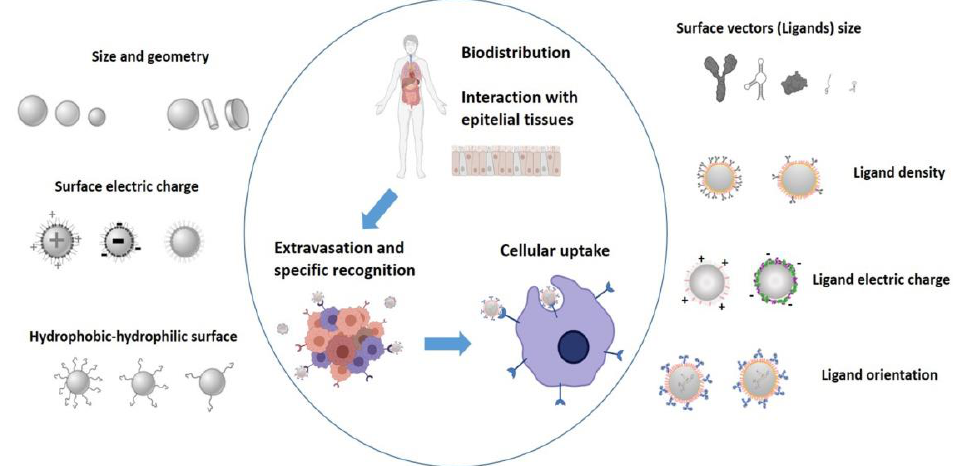
Figure 5. The physicochemical properties of the ligand and the NP affect their blood circulation profiles, biodistribution and their ability to be internalized by cancer cells. profiles, biodistribution and their ability to be internalized by cancer